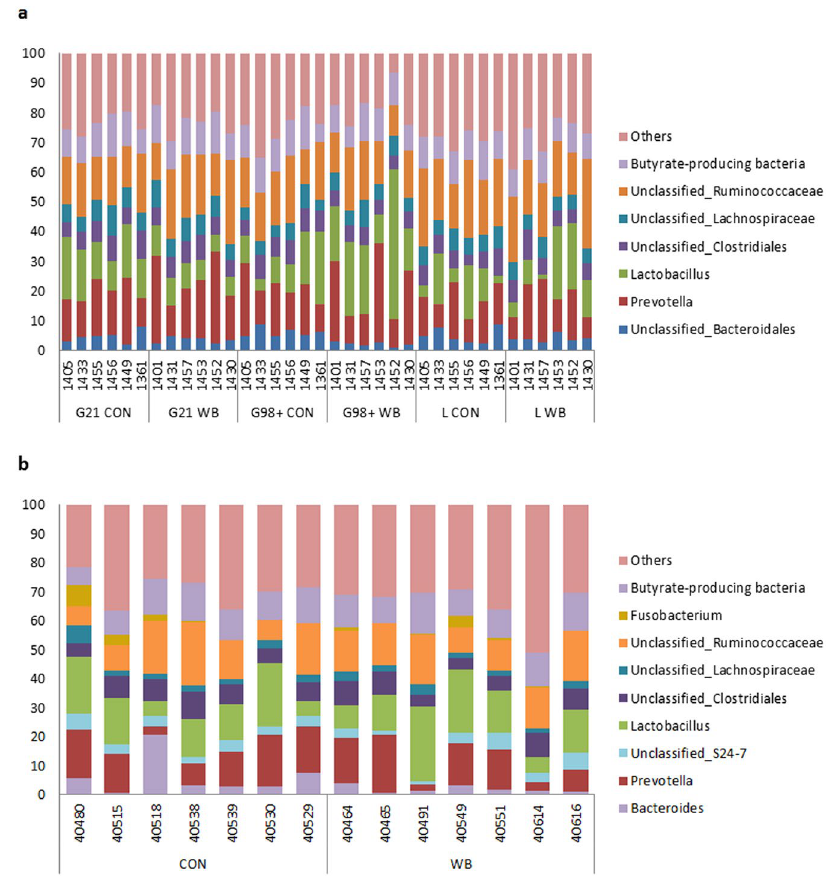
Figure 1. Individual composition of sows’ ( a ) and piglets’ ( b ) microbiota at the genus level. The Y-axis represents the relative abundances of the different genera (expressed as % of the total microbiota) and the X-axis represents the individuals (ID number).